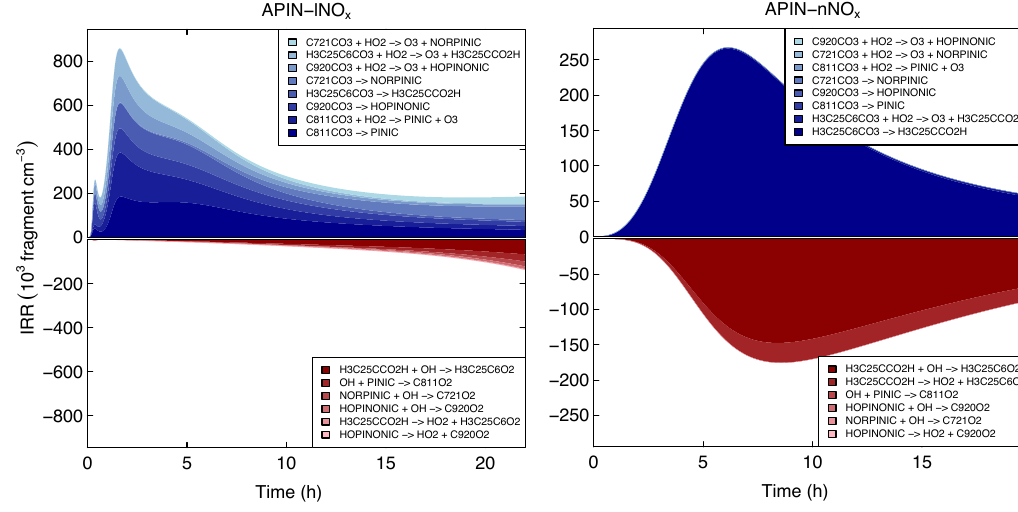
Figure 8. Integrated Reaction Rates for the COOH group (denoted in units of fragments per molecule).